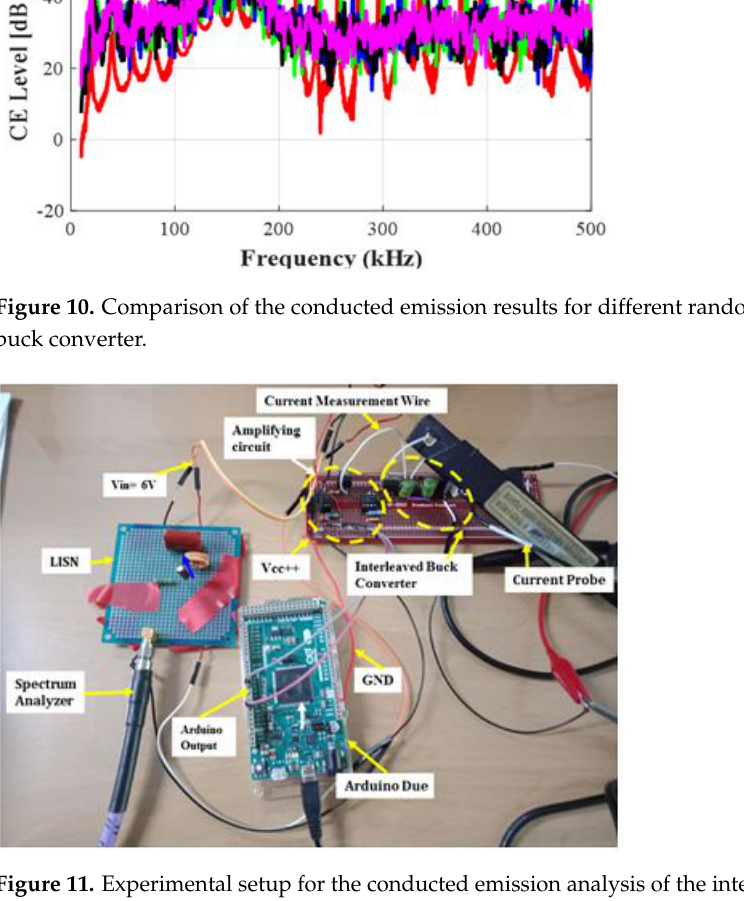
Figure 11. Experimental setup for the conducted emission analysis of the interleaved buck converter.